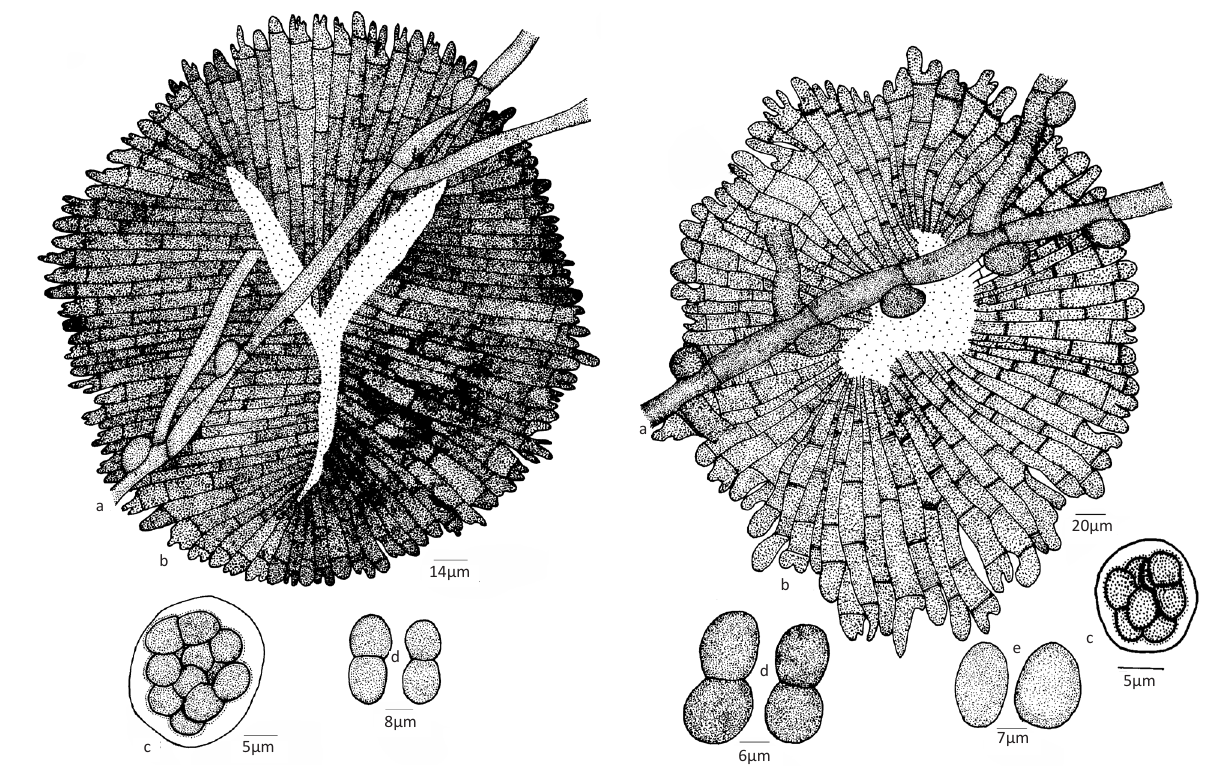
Figure 2. Asterina cassiigena sp. nov. a - Appressoriate mycelium; b - Thyriothecium; c - Ascus; d - Ascospores